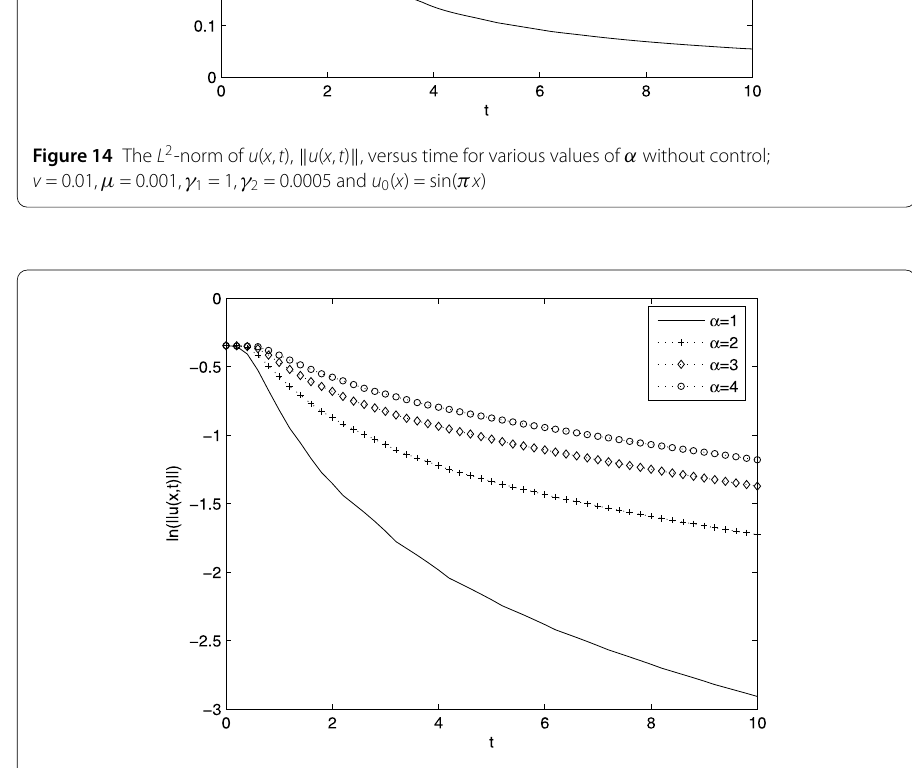
Figure 15 The natural logarithm of the L 2 -norm of u ( x , t ), ln( (cid:7) u ( x , t ) (cid:7) ), versus time for various values of α without control; v = 0.01, μ = 0.001, γ 1 = 1, γ 2 = 0.0005 and u 0 ( x ) = sin( π x )